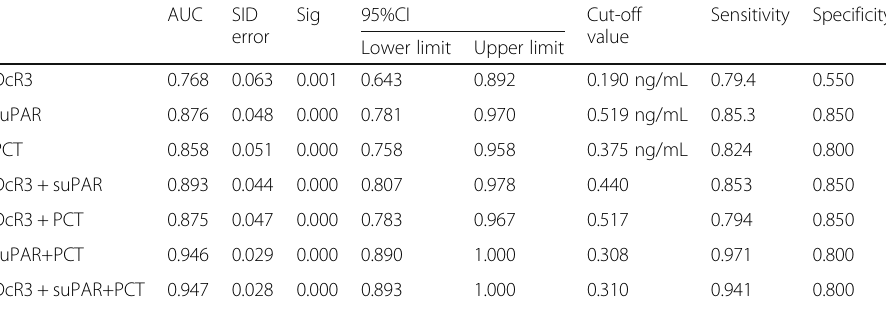
Table 2 Receiver operating characteristic analysis of DcR3, suPAR and PCT in control and